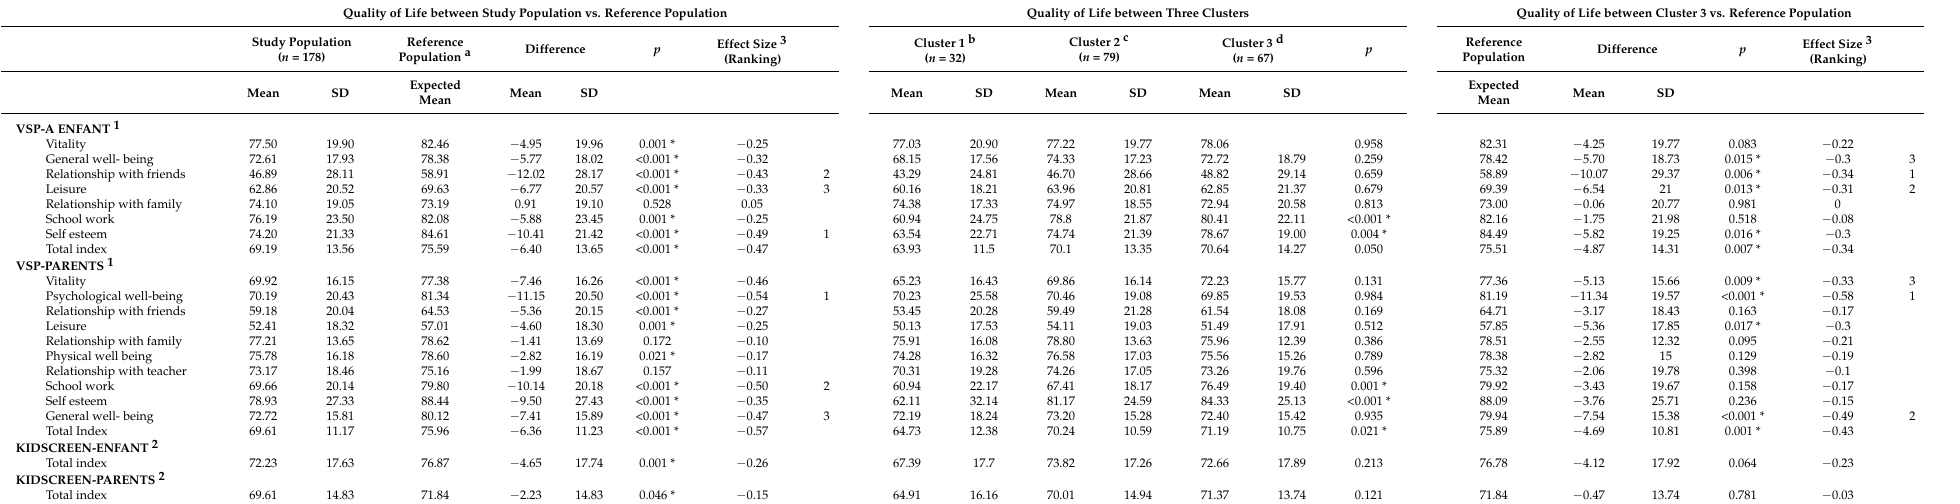
Table 2. Quality of life comparisons of studied ( n = 178) between cluster and reference